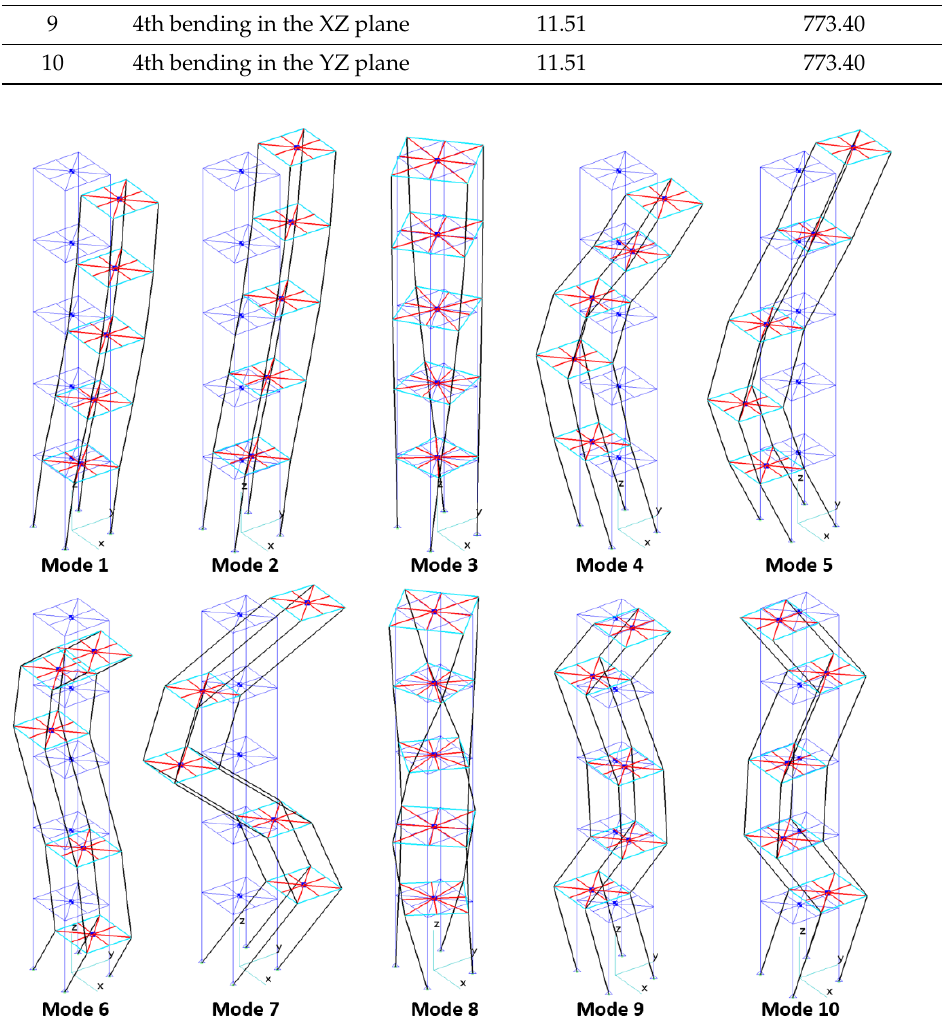
Figure 4. First 10 modes of the reference structure.